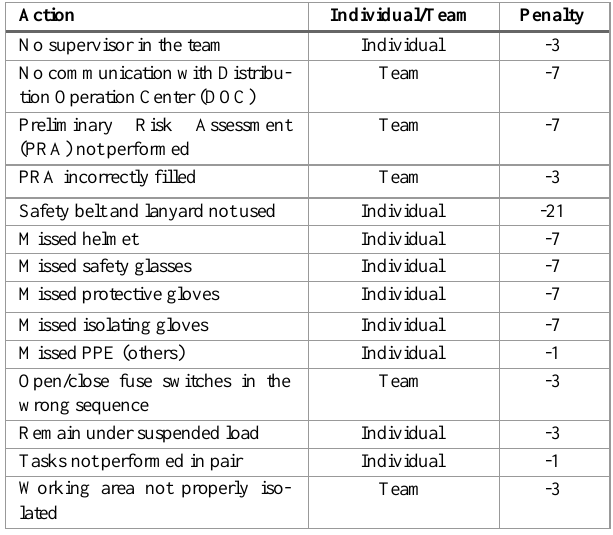
Table 3. Penalty scores based on